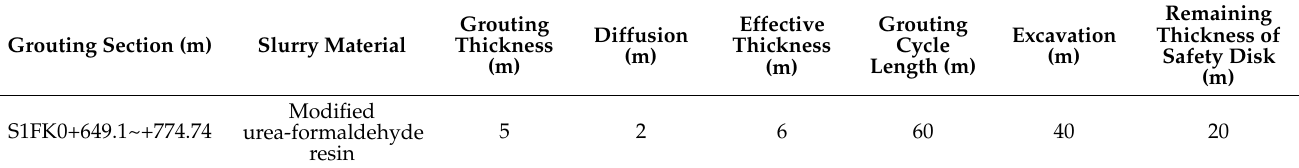
Table 3. Field grouting